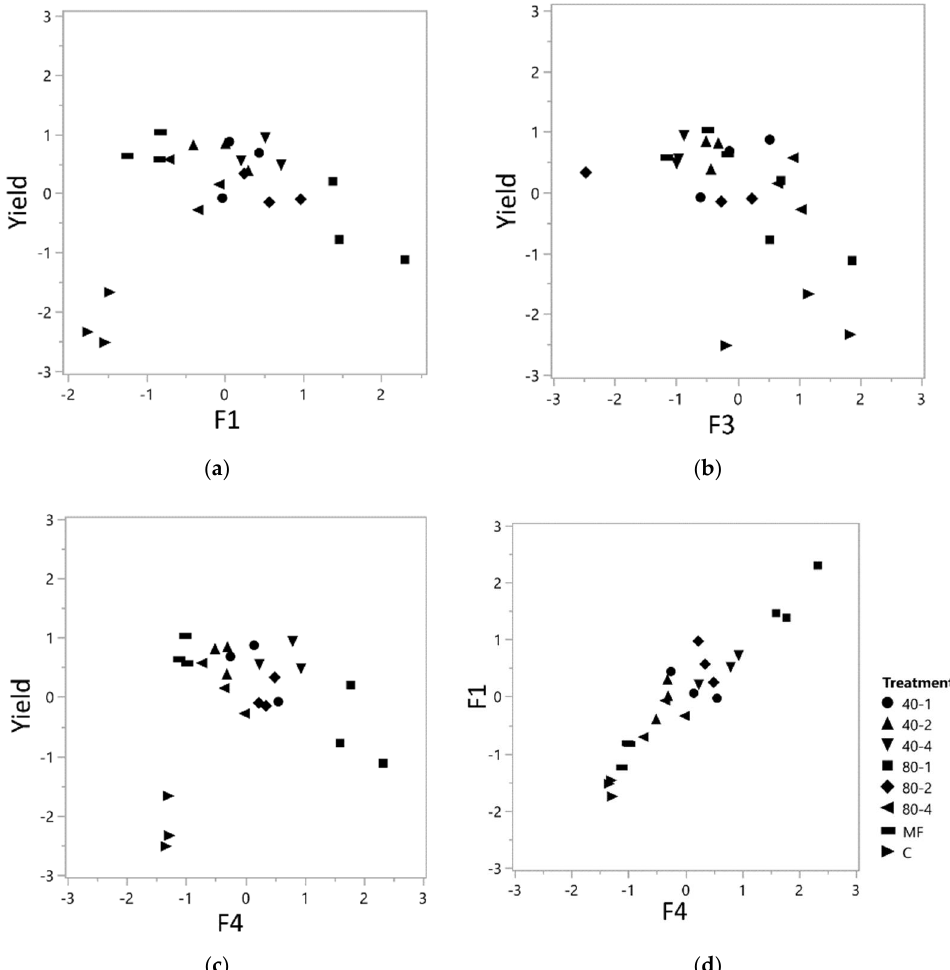
Figure 1. Relationship between soil quality assessment factors selected through PCA and yield. Treatments ( n = 3). ( a ) Yield × F1; ( b ) yield × F3; ( c ) yield × F4; ( d ) F1 × F4.